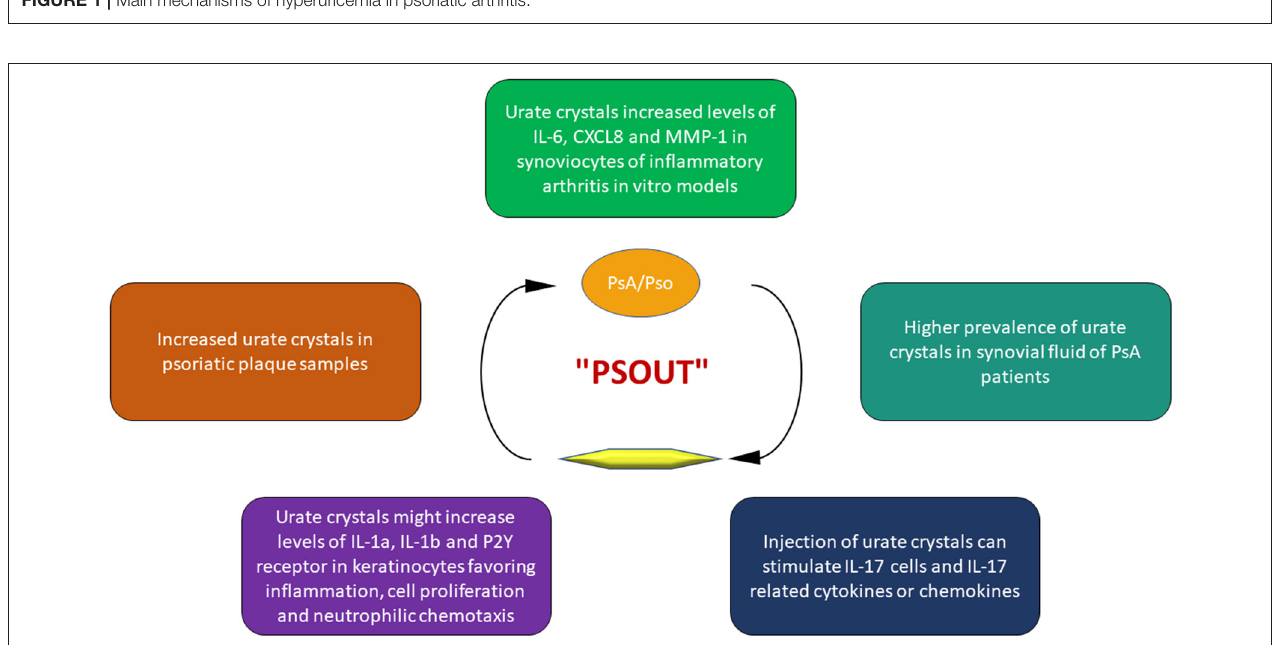
FIGURE 2 | Key points of the interplay between uric acid and psoriatic disease.